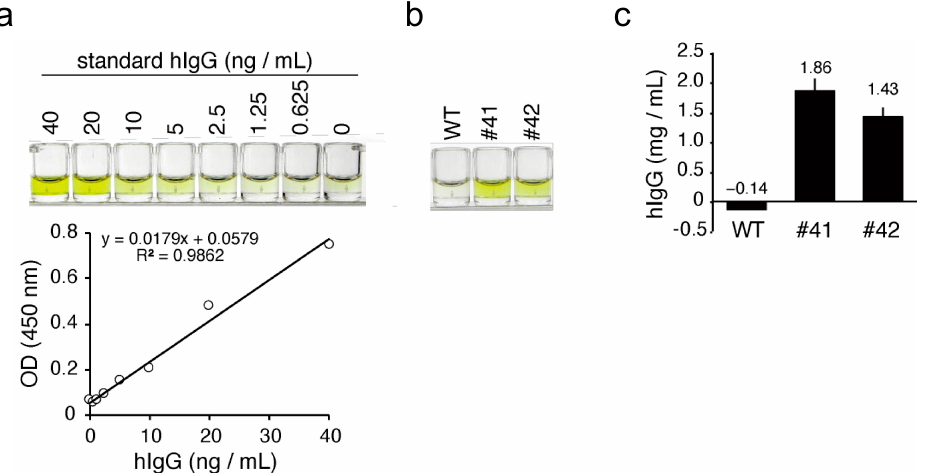
Figure 4. ELISA for hIgG in KI egg whites. ( a ) Top: color development of standard hIgG in ELISA. The concentrations of the standard hIgG samples are shown at the top of the wells. Bottom: standard curve based on the optical density (OD) values. R 2 is the linear regression R ‐ squared value. ( b ) Color development of hIgG from the WT and KI egg whites in ELISA. The WT and KI egg whites were diluted 100,000-fold and subjected to ELISA. The OD value of samples from WT, #41, and #42 eggs were 0.04, 0.42, and 0.33, respectively. ( c ) The concentration of hIgG in egg whites as estimated by ELISA. Bars show the mean ± standard deviation of the concentration of hIgG in each egg white sample (n =